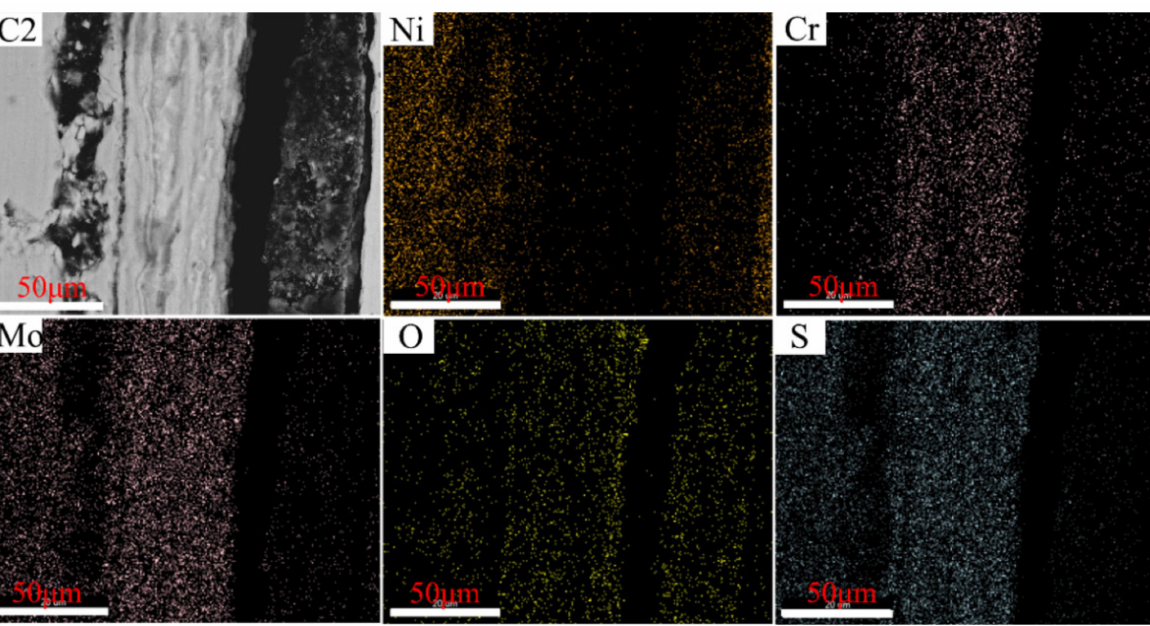
Figure 13. EDS maps of C2 cross-section after the sulfur corrosion test at 550 ◦ C for 168